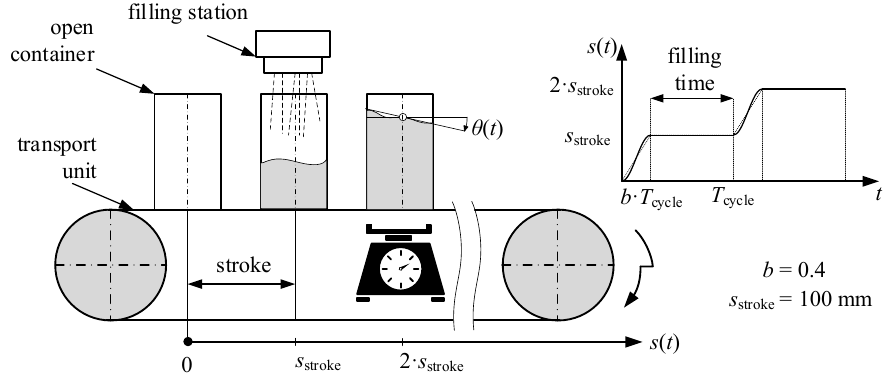
Figure 1. Principle of a filling unit applied in packaging machines. Empty, open containers are conveyed by a linear transport unit that realizes a rise-to-dwell-motion. After filling in the fluid, the filled container is conveyed to a weighing station, where the bottled fluid’s mass is controlled. For doing this, minimum residual vibration of the fluid’s surface is essential. The exemplary conveying motion consists of a motion time with length T mot = b · T cycle and a dwell phase of length ( 1 − b ) · T cycle . Here, a stroke of s stroke = 100mm as well as a ratio of motion time to cycle time of b = 0.4 are